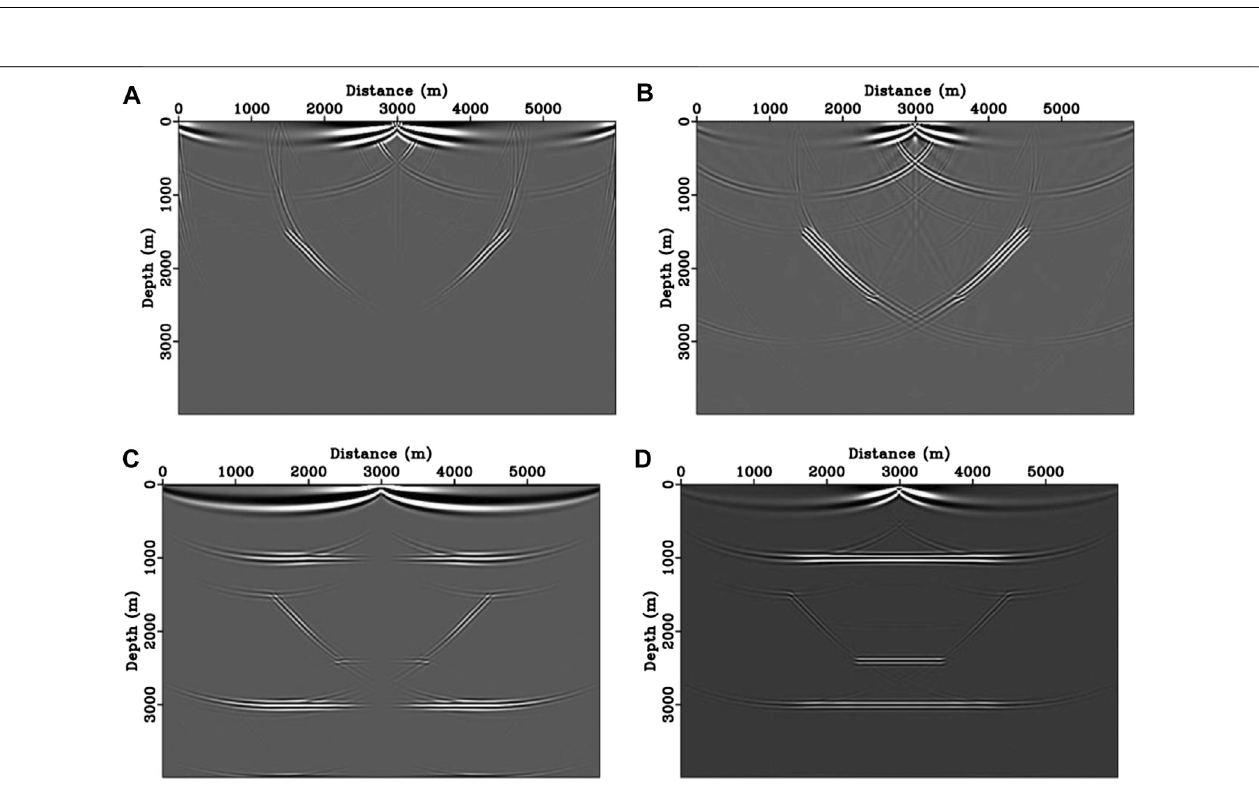
FIGURE 3 | The decoupled migrated images of z 2 x I ppxx (A) , z 2 x I ppzz (B) , z 2 z I ppxx (C), and z 2 z I ppzz (D) . The sum of decoupled migrated images z 2 x I ppxx , z 2 x I ppzz , z 2 z I ppxx , and z 2 z I ppzz is equal to the scalar imaging condition with a Laplace fi lter I lap pp . Otherwise, the sum of decoupled migrated images z 2 x I ppxx and z 2 z I ppzz is equal to the scalar imaging condition with a pseudo-Laplace fi lter I pse − lap pp